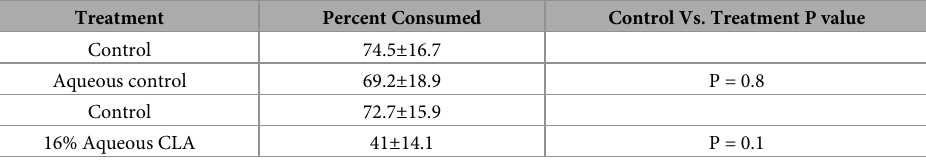
Table 3. Adult L . decemlineata choice assay of CLA applied to foliage as an aqueous